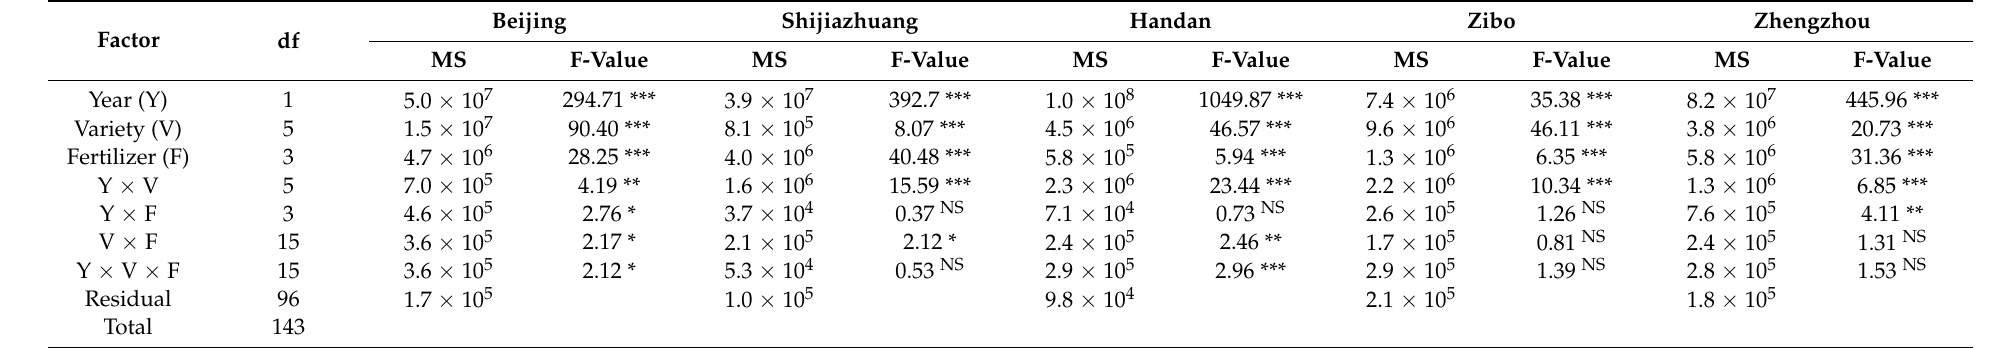
Table 6. ANOVA for yield traits studied along with its contribution toward total variation among six varieties of foxtail millet with four fertilizer treatments. Factor